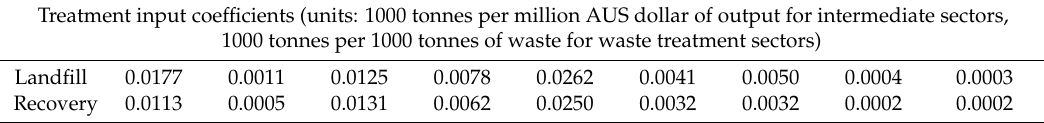
Table 9. The input coefficient matrix of Australian waste input output (WIO) table with waste treatment methods, 2010–2011.